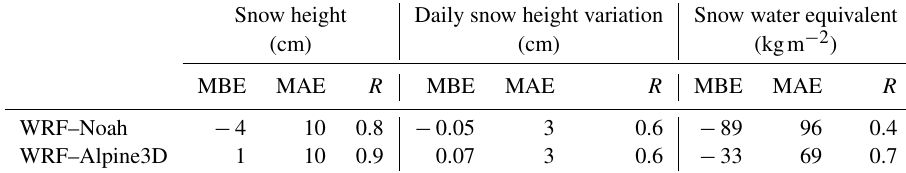
Table 4. WRF–Noah and WRF–Alpine3D mean bias error (MBE), mean absolute error (MAE) and correlation coefficient ( R ) for simulated snow height, daily snow height variation and snow water equivalent for the three snow